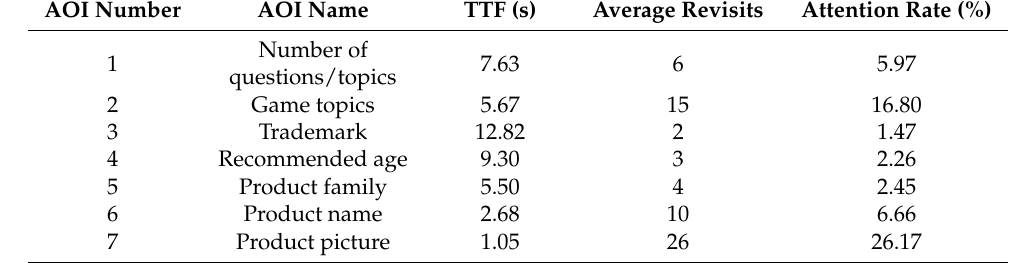
Table 4. Toy packaging. Time to First Fixation (TTF) and attention percentage of the total number of participants to each AOI. Source: Prepared by the authors.